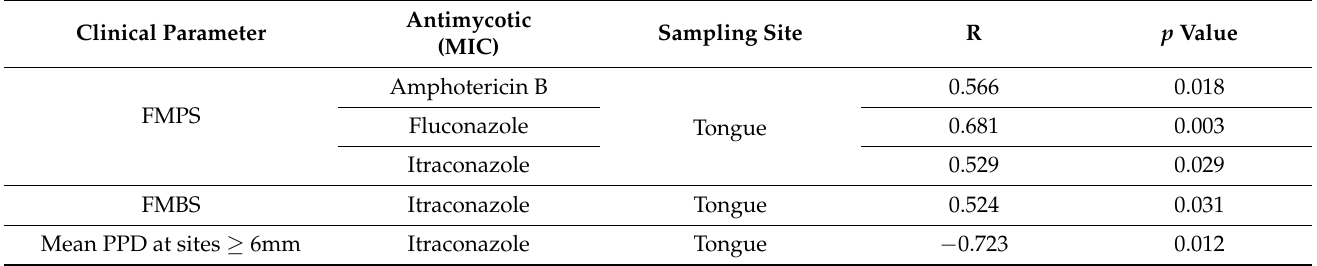
Table 3. Correlations between MIC values of tested antifungals and clinical periodontal